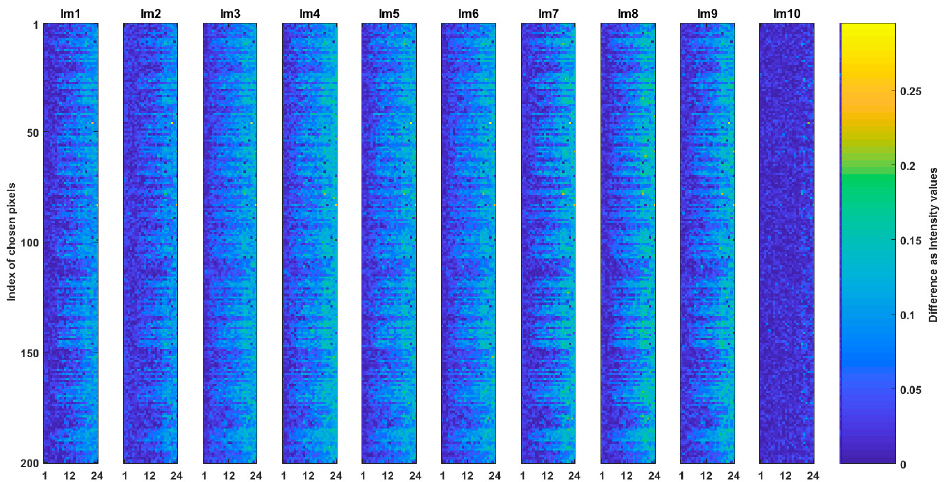
Figure 10. Comparison of ten SQ CEhex and SQ p images.